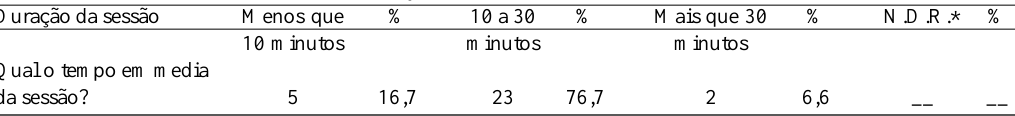
Tabela 4. Questionamento relacionado à duração das